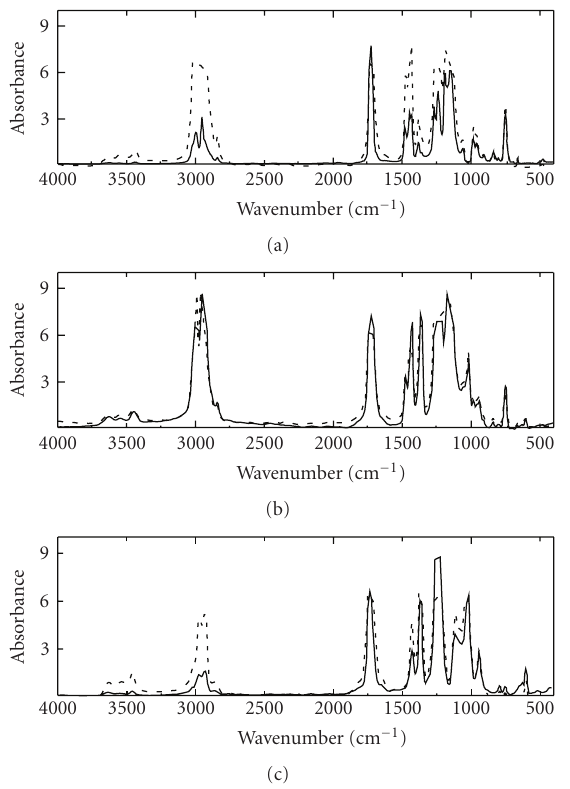
Figure 1: FT-IR spectra of (a) pure PMMA, (b) a blend of (50/50 PMMA/PVAc), and (c) pure PVAc before (—) and after exposure to UV radiation (- - -) for 24 hours.